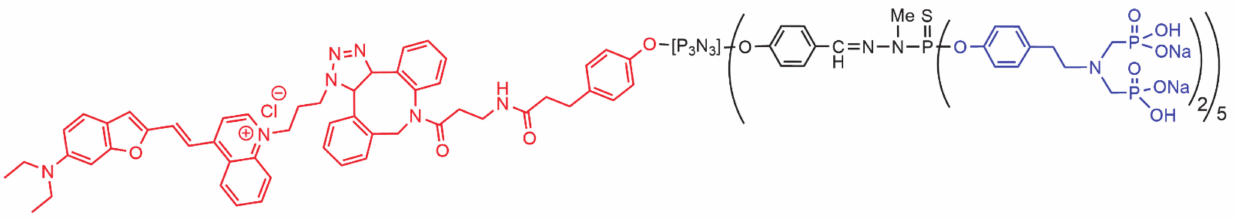
Figure 10. Dendron functionalized with a NIR fluorophore at the core and 10 azabisphosphonate derivatives on the